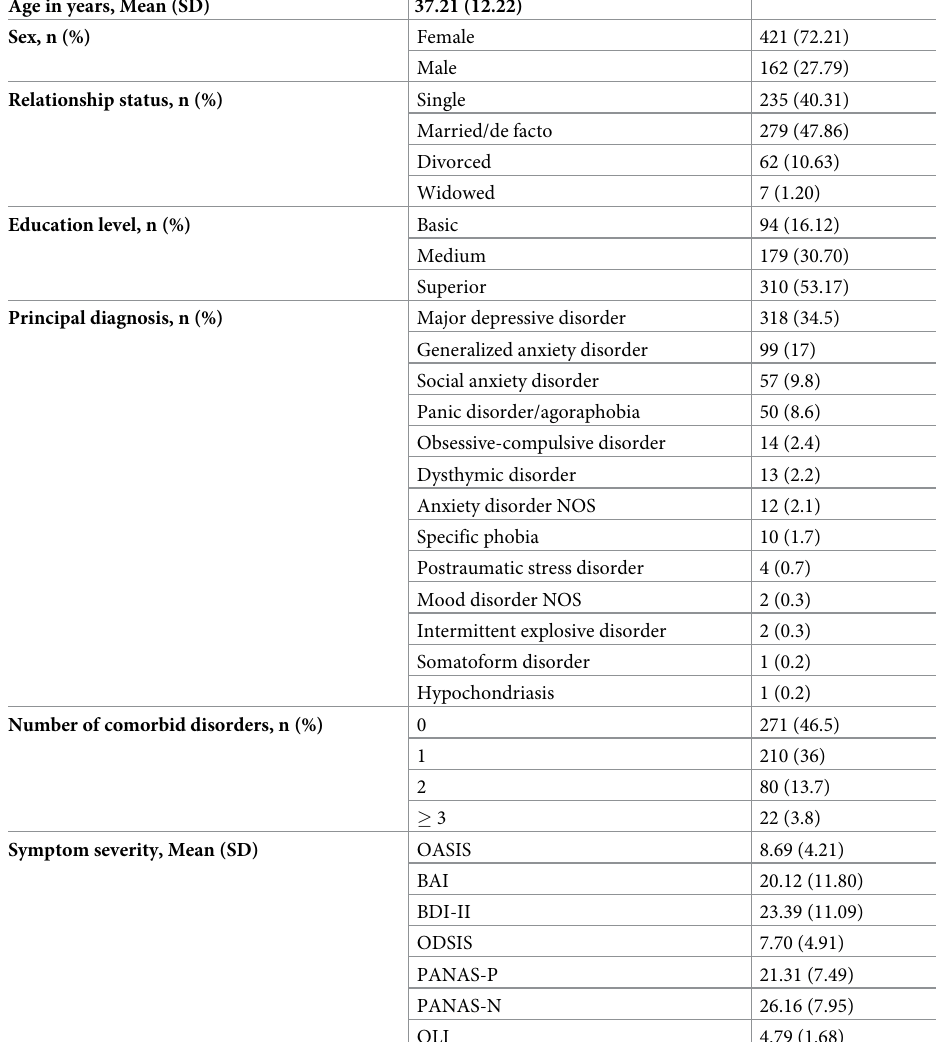
Table 1. Sociodemographic and clinical characteristics of the sample (n =